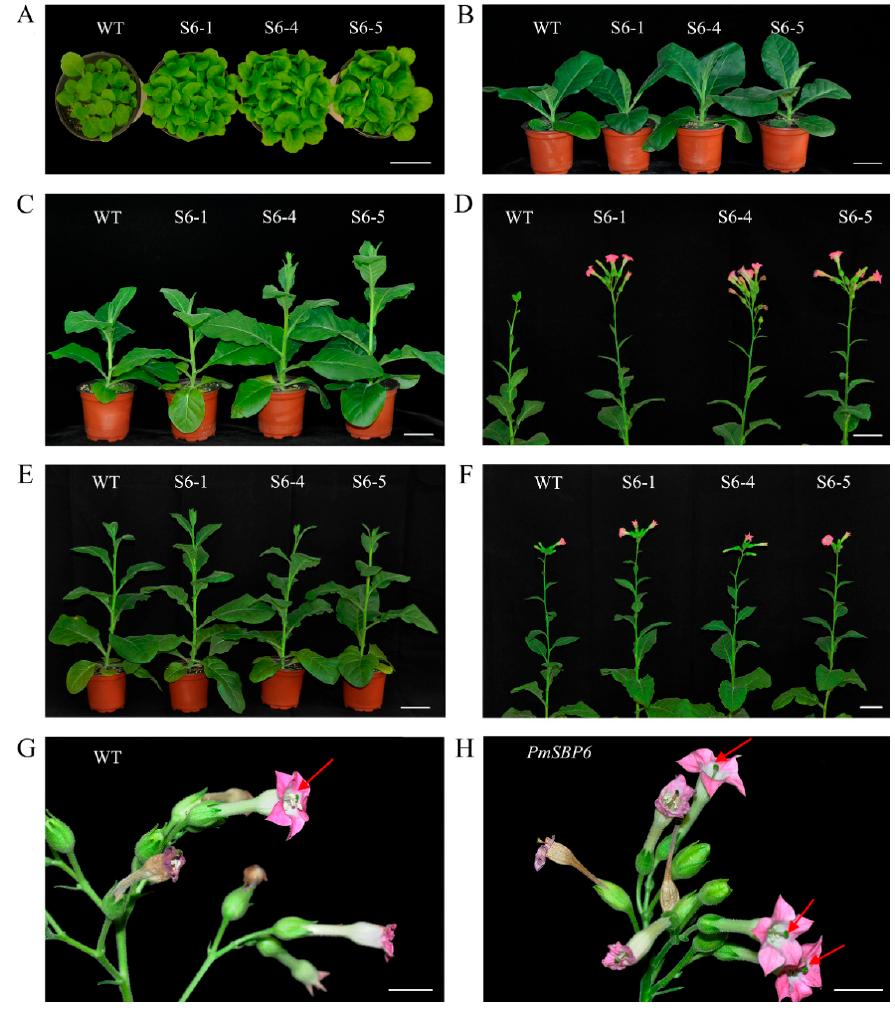
Figure 5. The phenotype of PmSBP6 transgenic plants. ( A , B ) The vegetative growth period of PmSBP6 transgenic plants (50 d and 80 d). ( C , D ) The flowering time of PmSBP6 transgenic plants grown in short-day conditions (90 d and 100 d). ( E , F ) The flowering time of PmSBP6 transgenic plants grown in long-day conditions (100 d and 110 d). ( G , H ) The flower phenotype of WT and the PmSBP6 transgenic tobacco. The red arrows indicate the relative height of stigma and stamen. The scale bar = 1 cm.